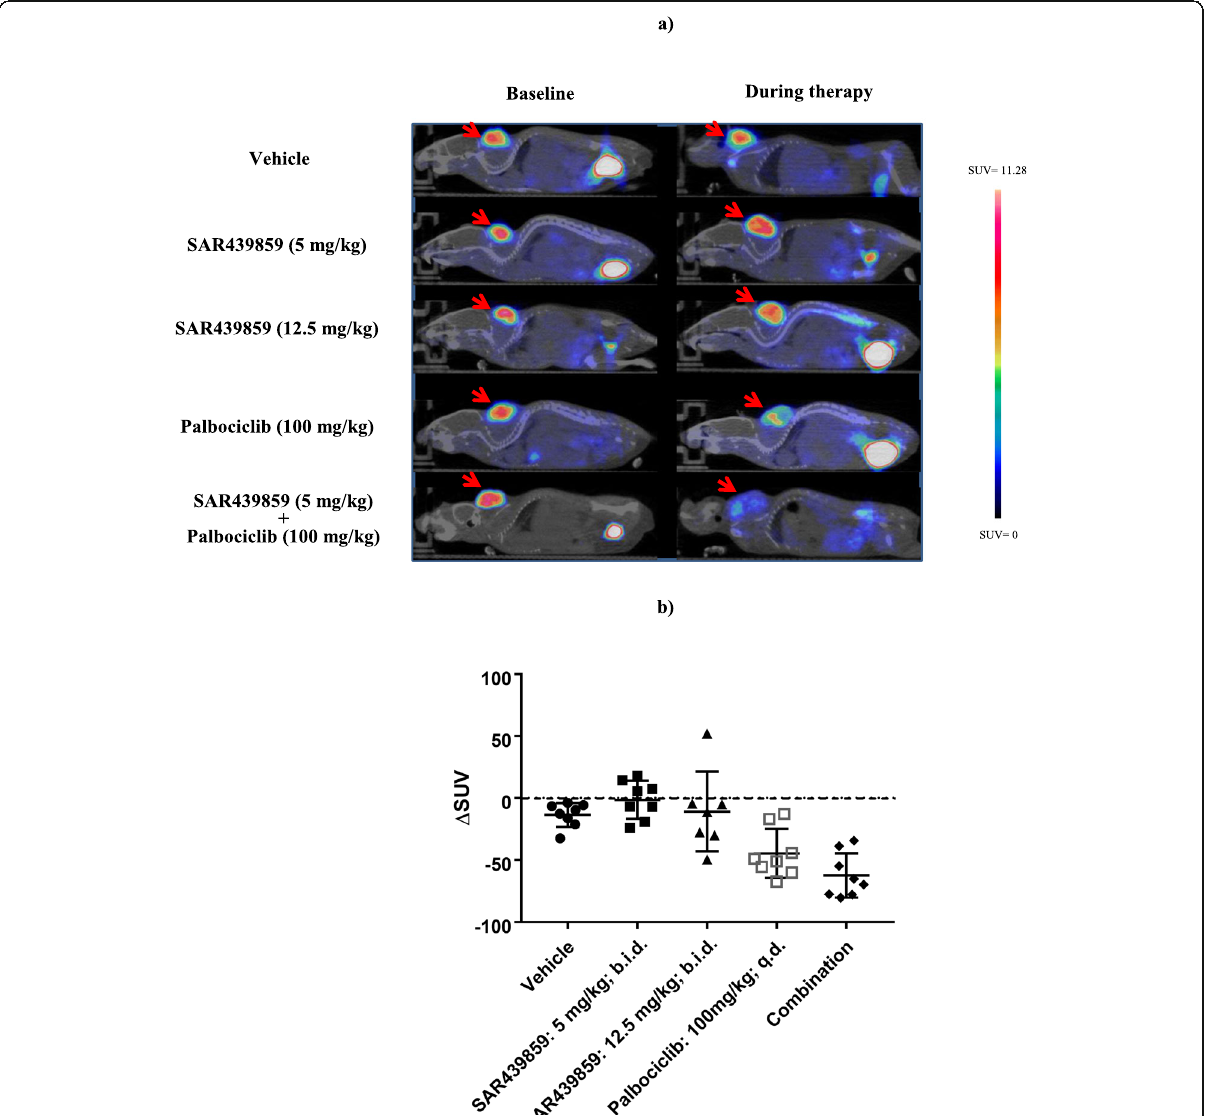
Fig. 5 a Comparison of fused FLT-PET scans obtained before and during therapy induction. b Quantitative analysis of [ 18 F]-FLT before and 72 h after treatment start with SAR439859 or palbociclib and the combination of the two. Data are expressed as Δ SUV (mean ±